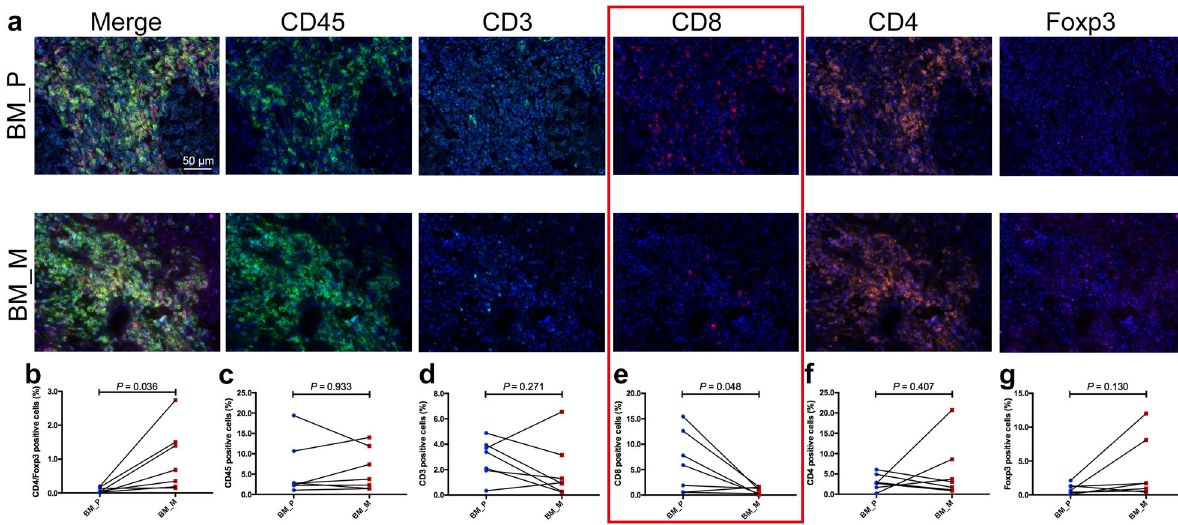
Fig. 5 Five immune related markers expression heterogeneity in tumor stroma of primary lesions and BM. a Representative images of multiplex immuno fl uorescence (MIF) of immune related markers including CD45 + , CD3 + , CD4 + , CD8 + , and Foxp3 + . MFI comparison of CD4 + Foxp3 + ( b ), CD45 + ( c ), CD3 + ( d ), CD8 + ( e ), CD4 + ( f ), and Foxp3 + ( g ) cells between primaries and BM. MFI mean fl uorescence